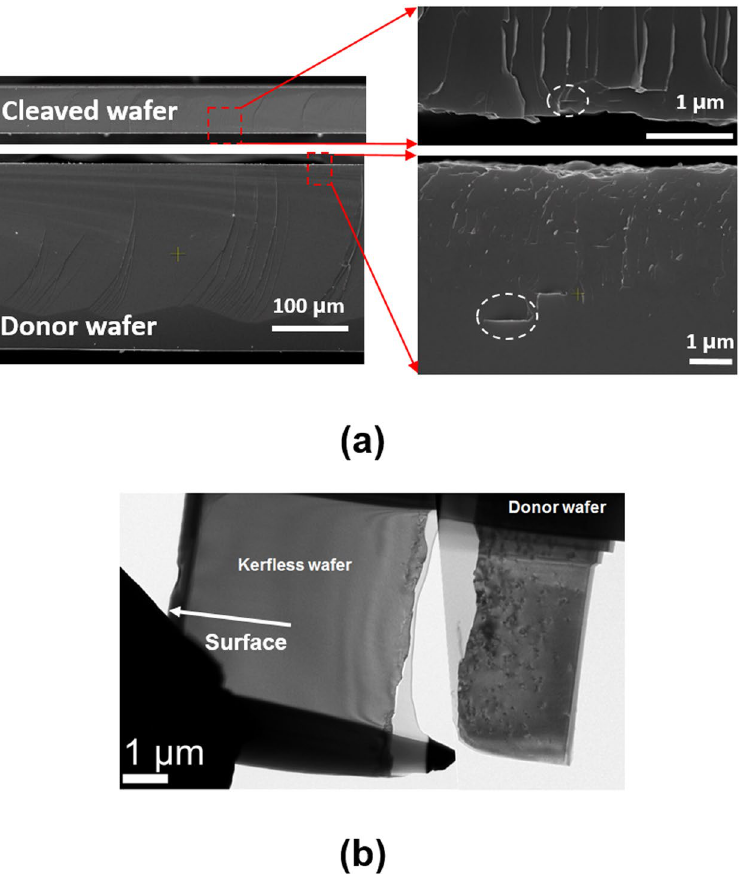
Figure 2. ( a ) Cross-sectional SEM images of the cleaved and donor wafers. The celaved sides on both of the wafers are magnified. One of the platelet defects are denoted by dashed circles in both of the cleaved and donor wafers. ( b ) Corss-sectional TEM images of the kerfless and donor wafers. The white arrow denotes the kerfless wafer surface side.